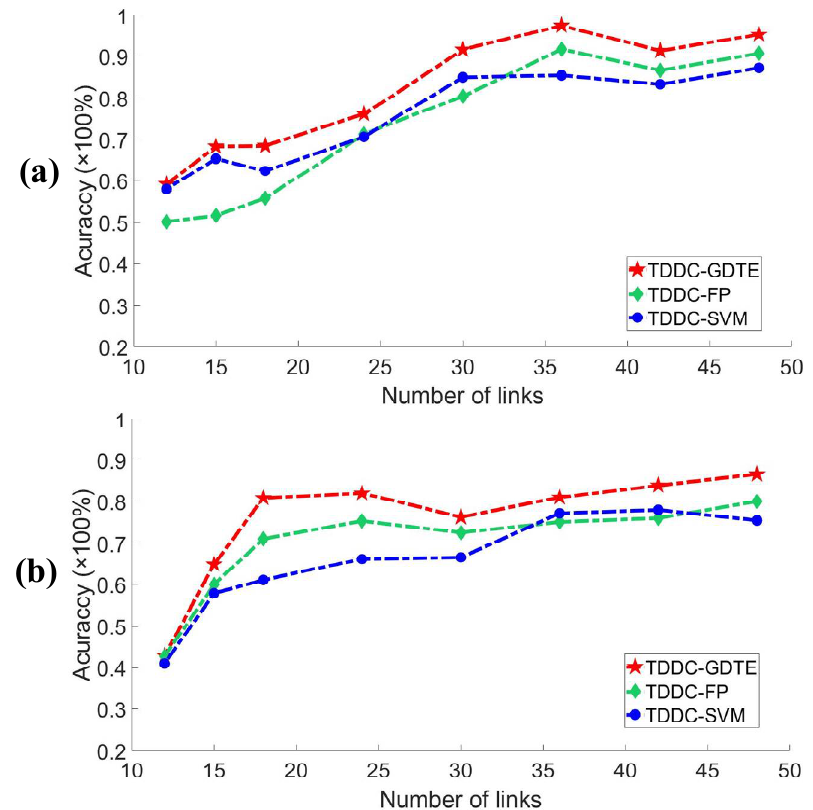
Figure 12. The localization accuracy varying with different numbers of links. ( a ) Experiment in STATE1. ( b ) Experiment in STATE2.